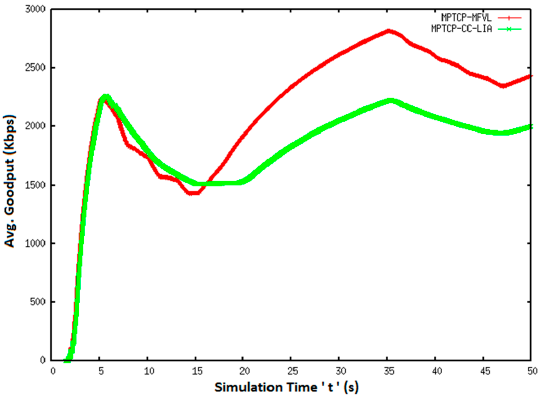
Figure 17. Average goodput result with CBR data rate of 2 Mbps.